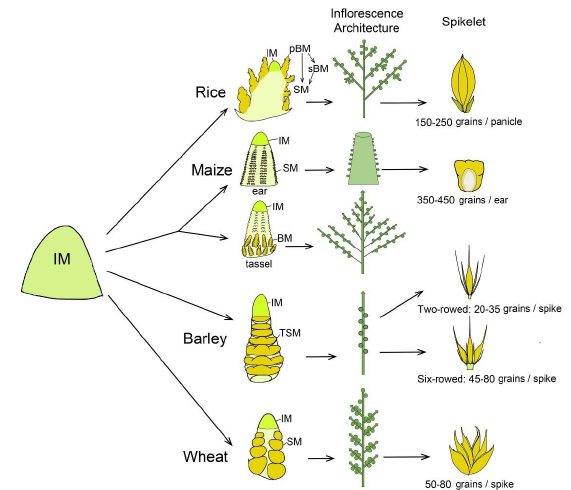
Figure 1. Schematic representation to compare inflorescence meristem differentiated fate, inflorescence architecture and spikelet in rice, maize, barley and wheat. In rice, inflorescence meristem (IM) generates two types of lateral branch meristems (BMs). The primary branch meristems (pBMs) generate spikelet meristems (SMs) and secondary branch meristems (sBMs). The sBMs further produce more SMs. In maize, IM of tassel is converted from shoot apical meristem, while the axillary meristem converts into an ear. The ear IM initiates a series of determinate axillary meristems, giving rise to pairs of SMs. The tassel produces BMs, which then form pairs of SMs. Each SM of ear and tassel further initiates two floret meristems (FMs). In barley and wheat, the IM directly differentiates SMs in axis without forming BMs. Barley has a triple spikelet meristem (TSM) structure composed of a central spikelet and two lateral spikelets, whose development is either suppressed to form a two-rowed type or promoted to form a six-rowed type. Conversely, in wheat, the inflorescence is composed of single spikelet that produce multiple FMs.